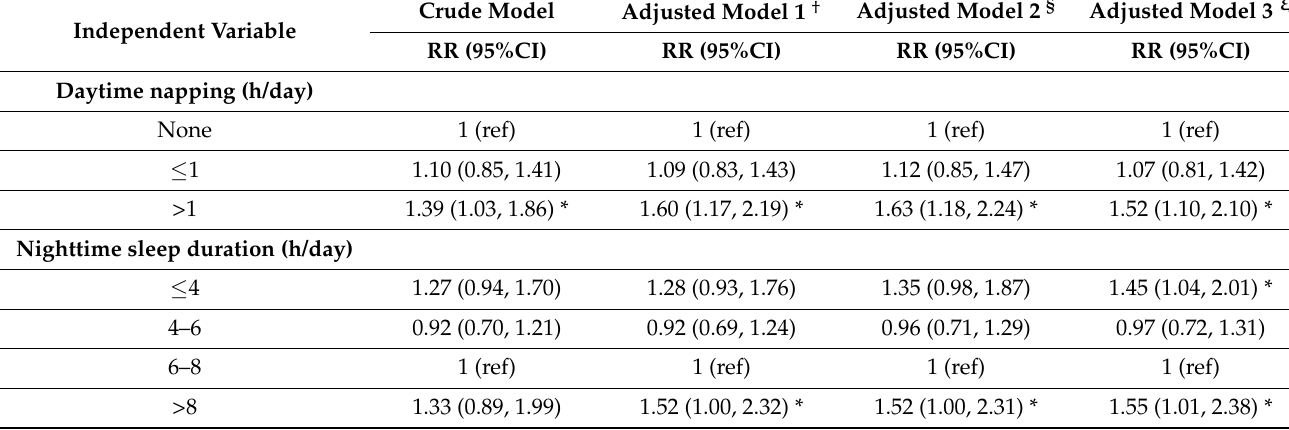
Table 3. Associations between daytime napping and nighttime sleep duration with the risk of diabetes mellitus. Independent Variable